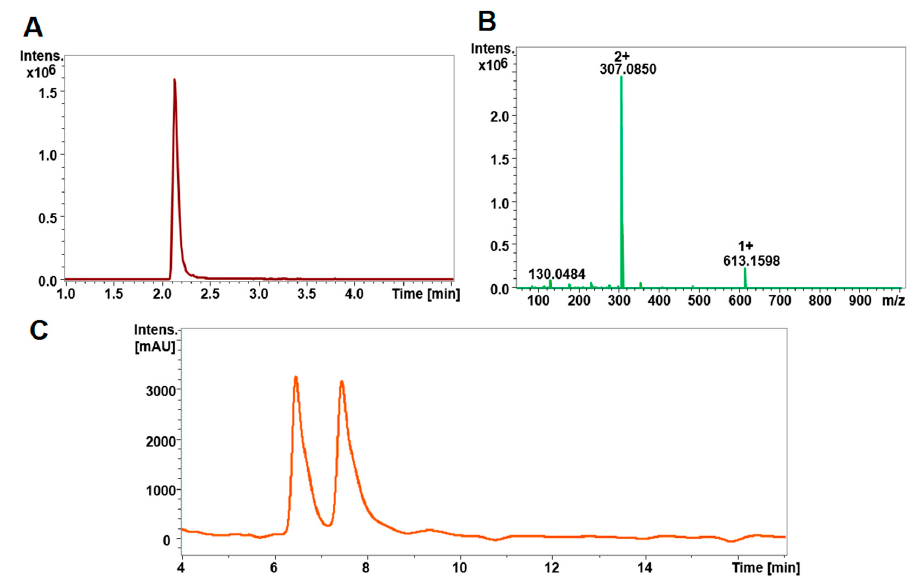
Figure 1. Chromatographic separation and detection of GSSG and GS-NEM. ( A ) Extracted ion chromatogram (XIC) and ( B ) mass spectrum of GSSG standard measured by HPLC-ESI-QTO-FMS. ( C ) GS-NEM was measured by HPLC-UV and the trace at 210 nm is shown. The doubly charged ion of